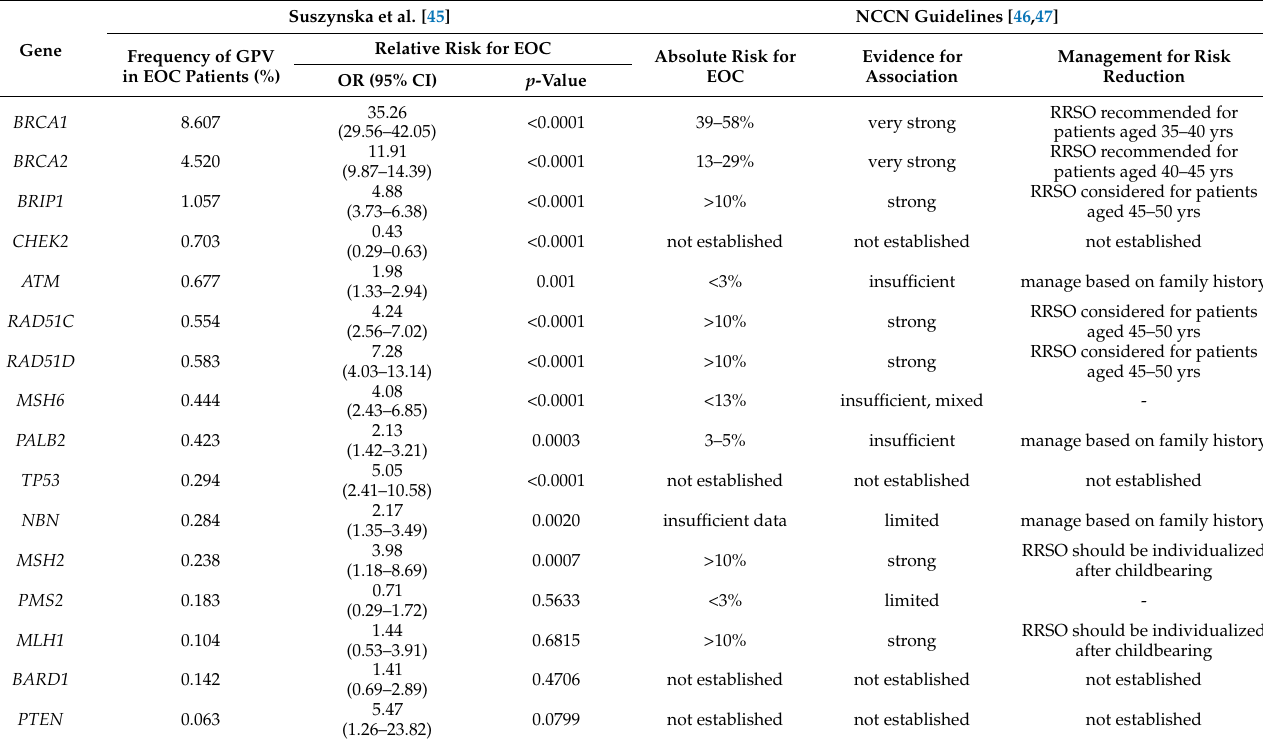
Table 1. Frequency of germline pathogenic variants in patients with epithelial ovarian cancers (EOC), relative and absolute risks for EOC, and risk reduction for EOC in each predisposition gene. Suszynska et al.